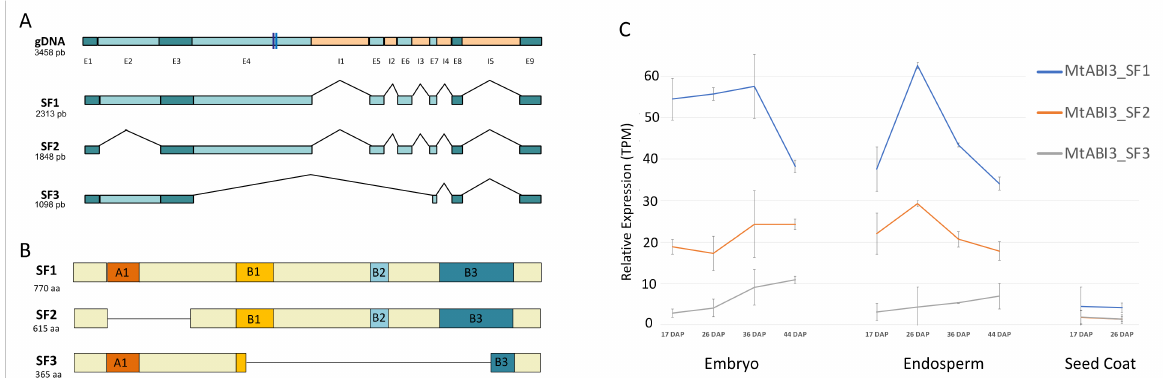
Figure 2. Medicago ABI3 gene displayed three splicing isoforms. ( A ) Schematic description of the whole gDNA and three splicing isoform structures of MtABI3 with exons and introns and corresponding size in bp. Dark and blue lines in exon 4 represent the locations of the insertional Tnt1 transposable elements that characterize the two Medicago mutant lines abi3-1 (NF3185) and abi3-2 (NF6003). ( B ) Schematic description of different ABI3 protein isoforms with different activating and binding domains and corresponding sizes in amino acids. ( C ) Tentative expression profiling of ABI3 splicing isoforms using RNA-seq data produced from isolated seed tissues (i.e., embryo, endosperm, and seed coat) at four developmental seed stages using the Salmon algorithm. Relative expressions profiles of isoforms represent the raw read counts normalized by the library size and the transcript length and expressed in transcript per million